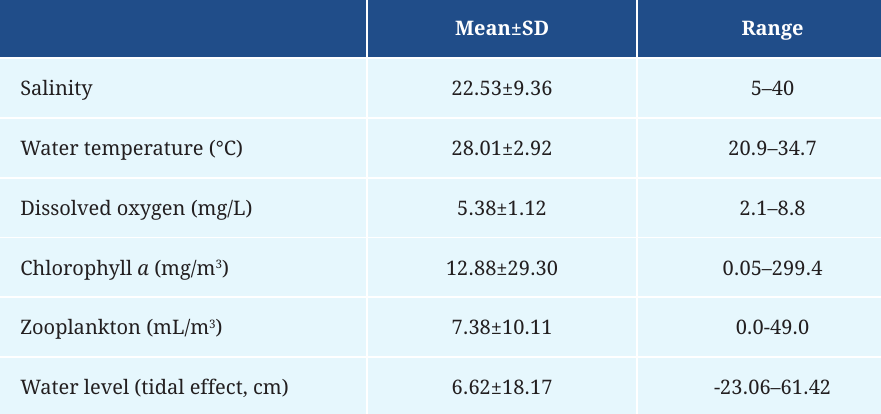
TABLE 1 | Mean values, standard deviations (SD), and range of environmental parameters of La Mancha lagoon, recorded throughout the 19 months of